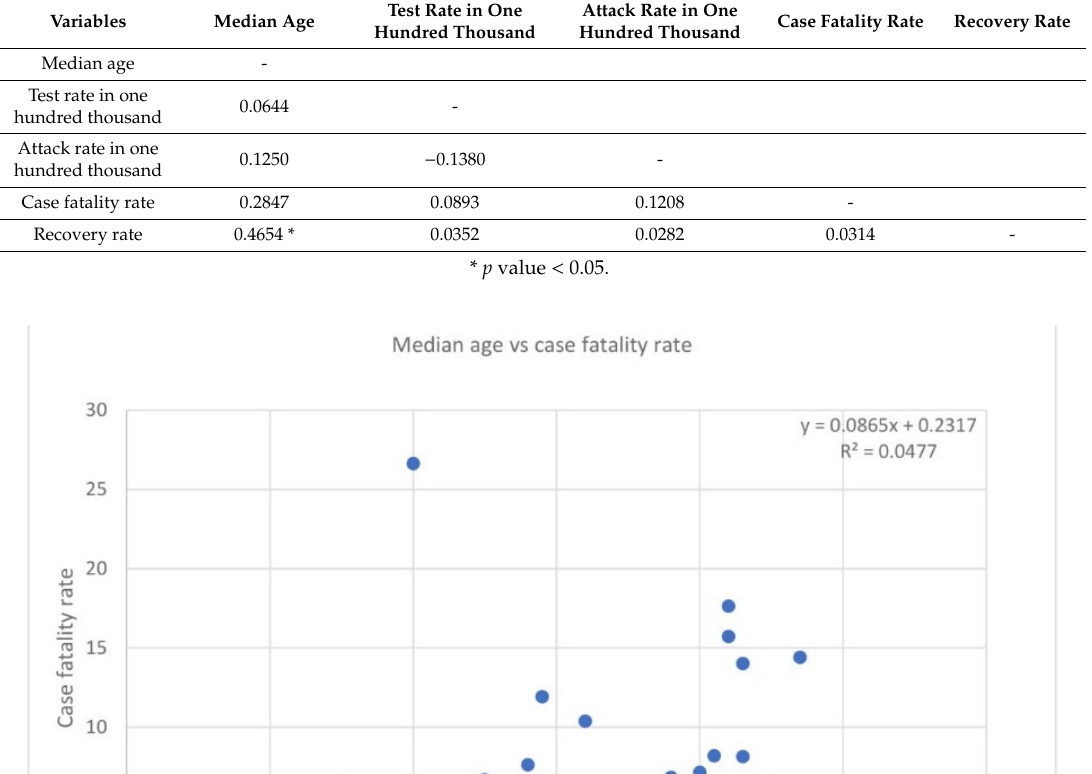
Figure 2. Correlation between median age and recovery rate.